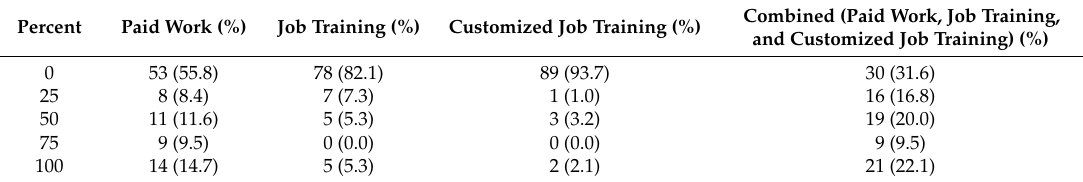
Table 2. Return to work 12 months after start of rehabilitation ( n =